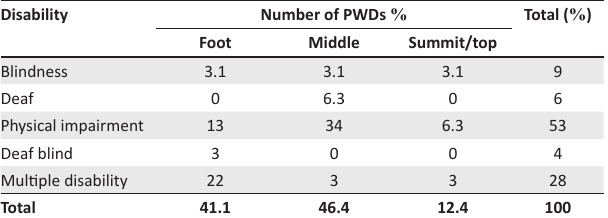
TABLE 1: Landslide risk of persons with disabilities’ (PWDs) households due to slope positions.